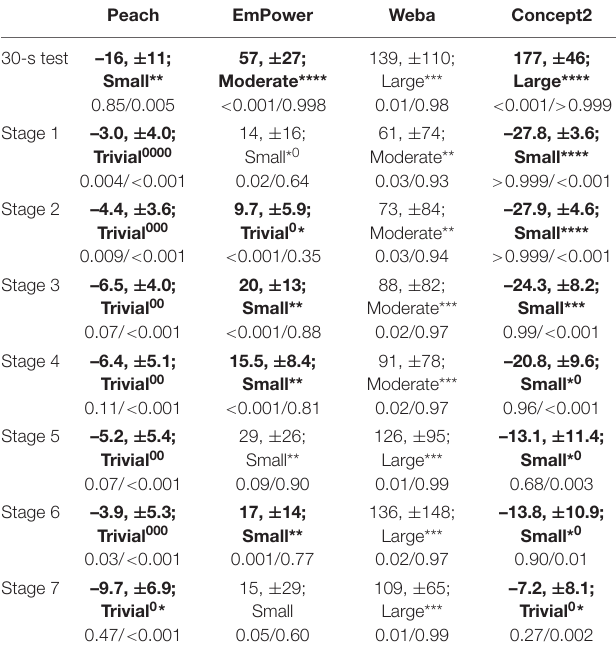
TABLE 4 | Differences in the mean SD of power from the Reference System across the stages for Peach, EmPower, Weba, and the Concept2. Data are mean (%), ± 90% compatibility limits, with observed magnitude and p -values for inferiority and superiority tests ( p − / p +